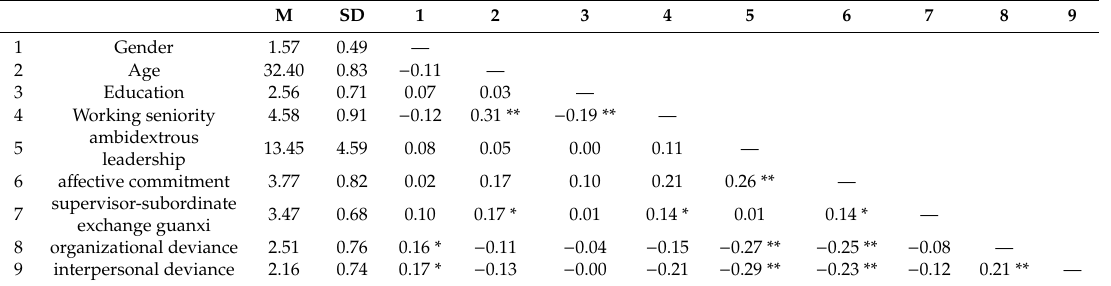
Table 2. Means, standard deviation, and correlations of variables.